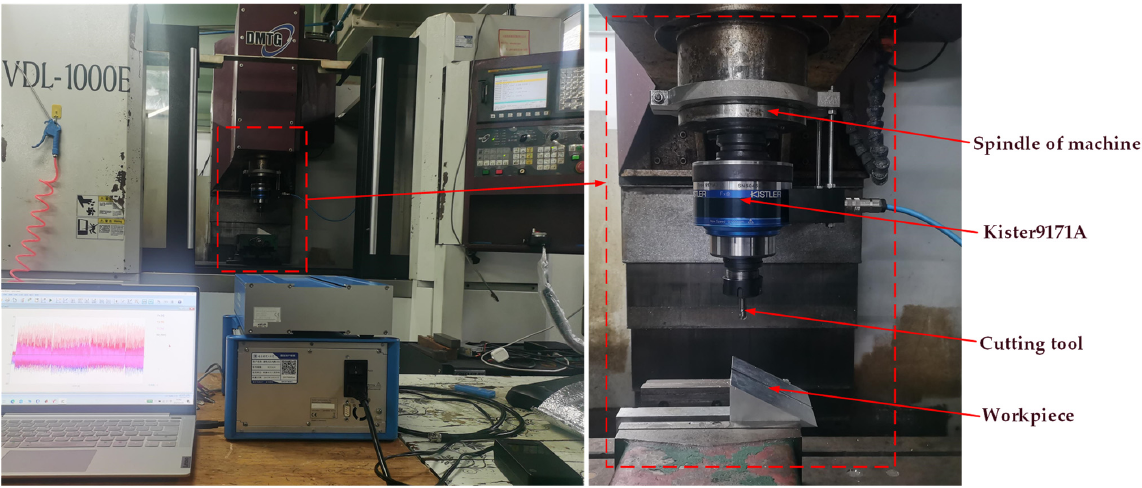
Figure 17. Cutting force test layout.